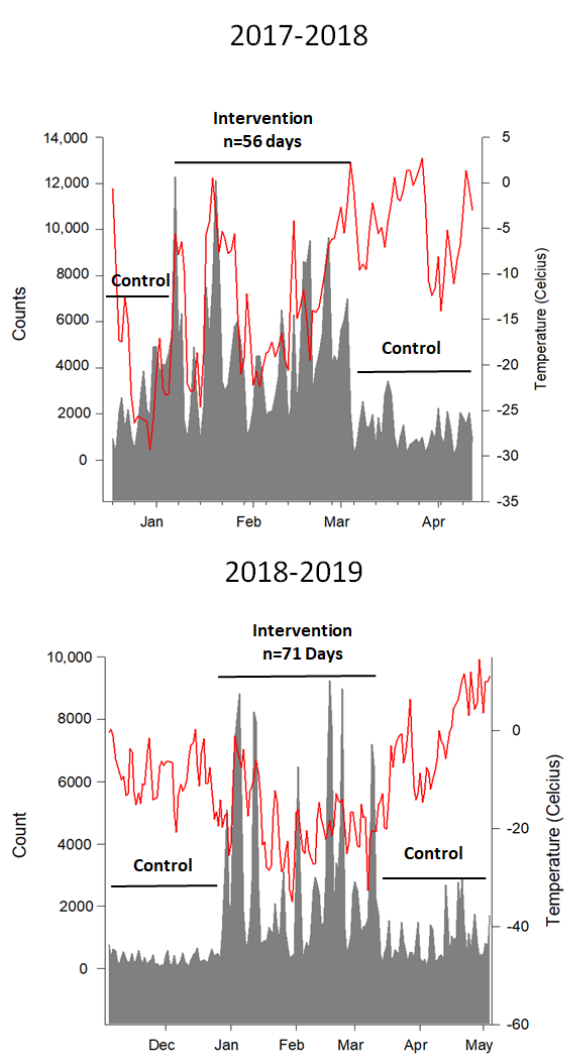
Figure 4. Objectively measured trail visits before, during, and after the opening of the frozen waterway trail. Red line = temperature (Y2 axis); grey filled line = daily user counts during control and intervention periods. Lines for control and intervention periods correspond to dates of data collection.